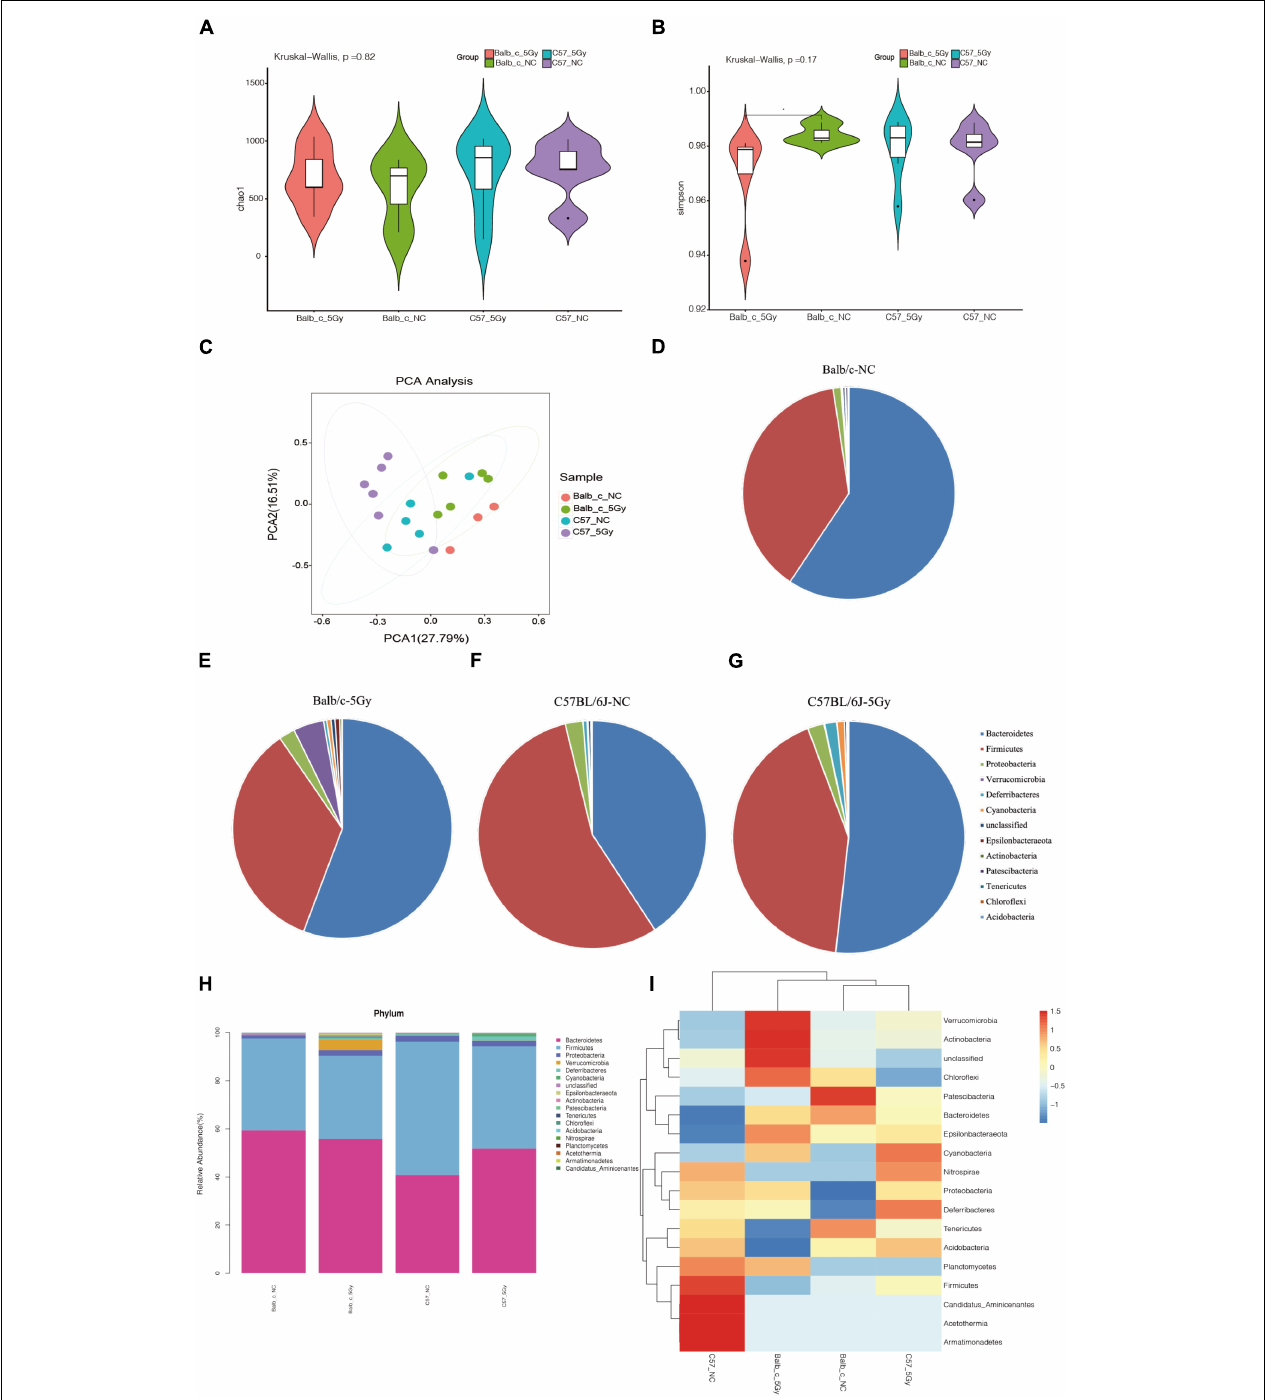
FIGURE 2 | Changes of gut microbiota after proton irradiation in each group at phylum level. (A) The Alpha diversity assessed by richness (Chao1) and (B) evenness diversity (Simpson) of the intestinal bacteria in male mice at days 3 post-proton irradiation were examined by 16S high-throughput sequencing. (Wilcoxon, * p < 0.05). (C) Principal Component Analysis (PCA) score plots based on Bray–Curtis distance at phylum level. Average abundance of bacterial phyla in the Balb/c-NC (D) , Balb/c-5Gy (E) , C57BL/6J-NC (F) , and C57BL/6J-5Gy (G) mice intestinal microbiota. (H) Taxonomic summary of the gut microbiota of Balb/c and C57BL/6J at phylum level. (I) Heatmap analysis of gut microbiota changes from different mice group at phylum level. (Mean ± SD; Balb/c-NC: n = 3; Balb/c-5Gy: n = 6; C57BL/6J-NC: n = 6; C57BL/6J-5Gy: n = 6).